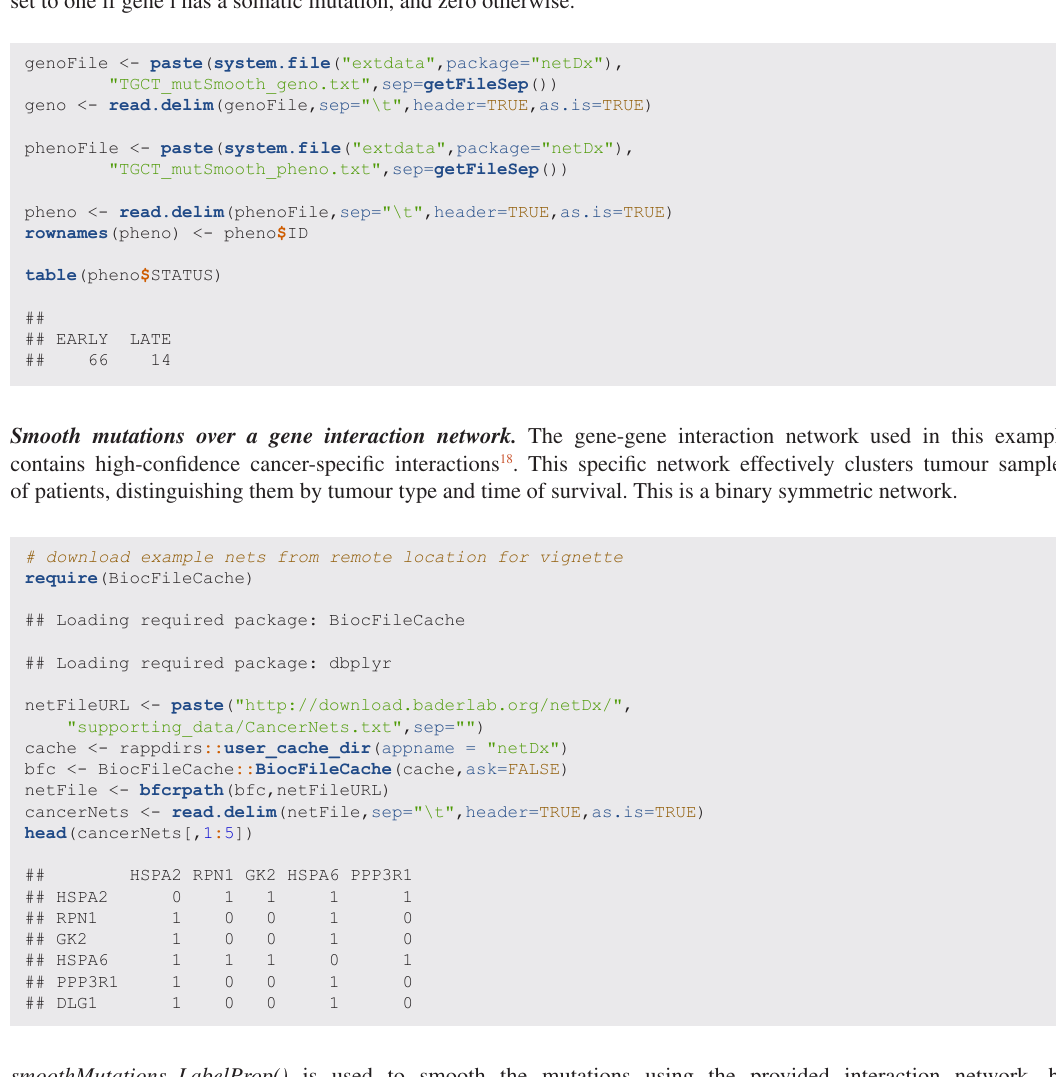
Setup set.seed (8) suppressWarnings ( suppressMessages ( require (netDx))) suppressWarnings ( suppressMessages ( require (MultiAssayExperiment))) Data. Clinical and genetic data are downloaded using the Bioconductor package curatedTCGAData . Muta- tions are converted to a binary matrix format where rows represent genes, columns represent patients; entry [i,j] is set to one if gene i has a somatic mutation, and zero otherwise.